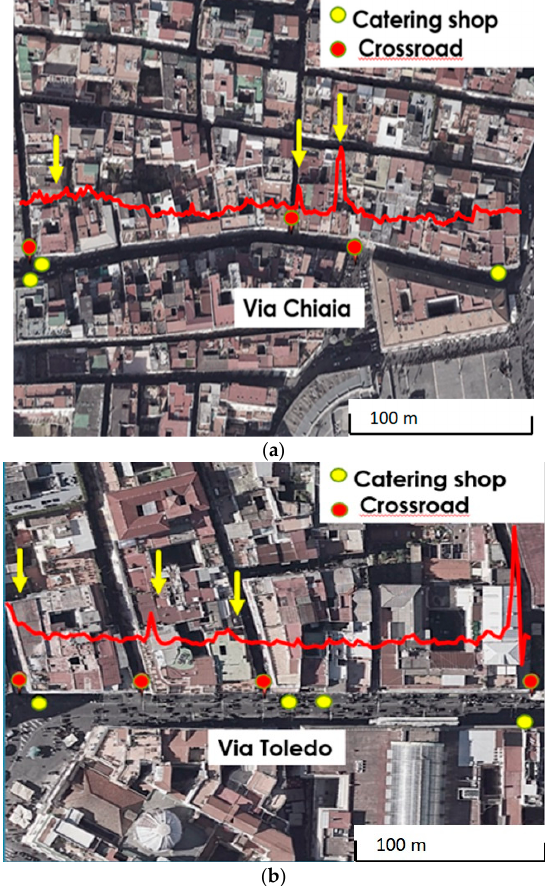
Figure 4. Spatial distribution of FPs concentration in pedestrian streets—( a ) via Chiaia and ( b ) via Toledo. Yellow circles indicate the presence of a food establishment while red ones correspond to junctions with trafficked streets.